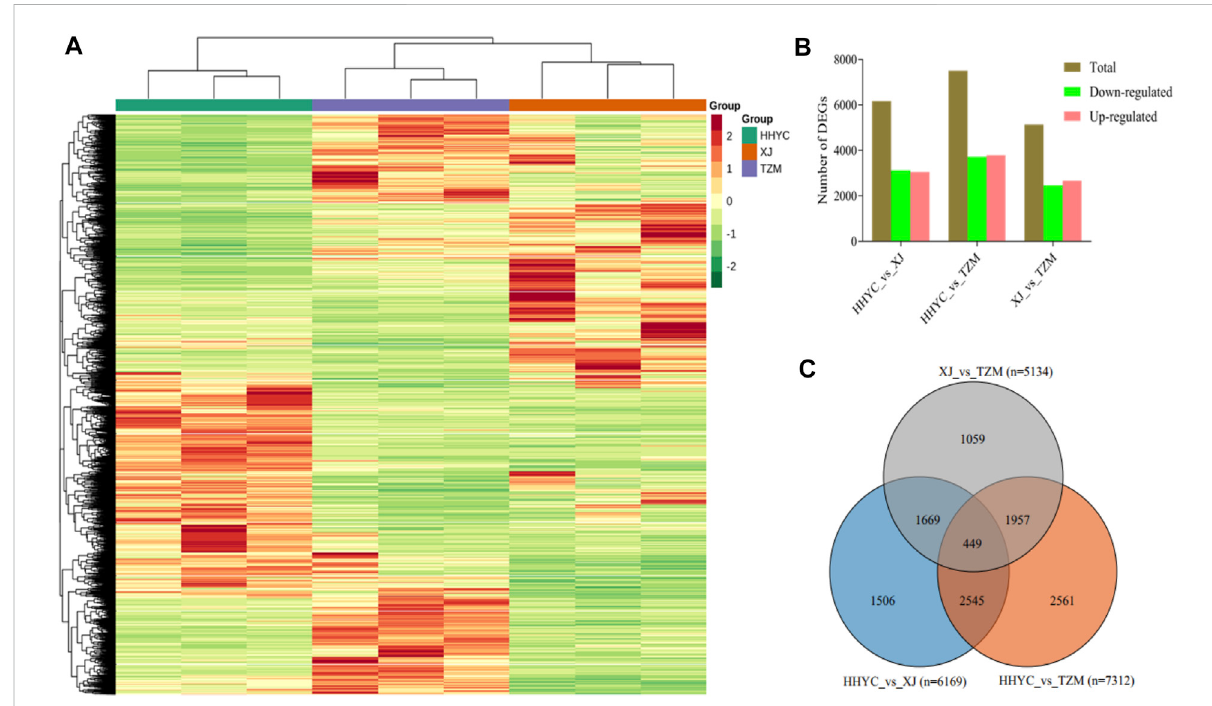
FIGURE 3 Differentially expressed genes in the three contrasting fl owers of C. reticulata (HHYC), C. reticulata ‘ Xuejiao ’ (XJ) and C. reticulata ‘ Tongzimian ’ (TZM). (A). Hierarchical clustering heatmap based on fragments per kilobase of exon per million fragments mapped of differentially expressed genes (DEGs)ofthethreesamples(HHYC,XJandTZM)basedontriplicatebiologicalrepeats.Thered,blueandgreencolorsoncolumncluster(shownright hand side) represent HHYC, XJ and TZM, respectively. (B) . Extent of regulation of DEGs. (C) . Venn diagram of DEGs among the three pairwise group comparisons (n = number of DEGs